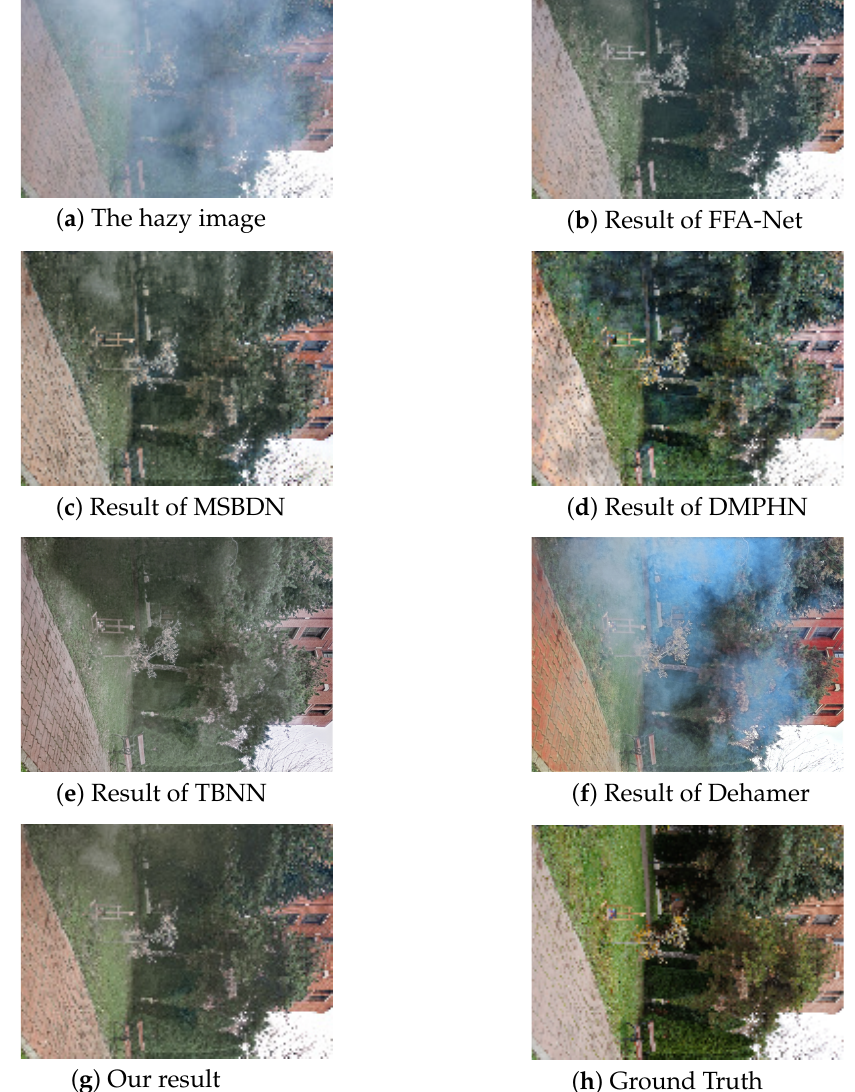
Figure 5. Qualitative comparison of dehazing results on another nonhomogeneous hazy image from NH-Haze (2021)